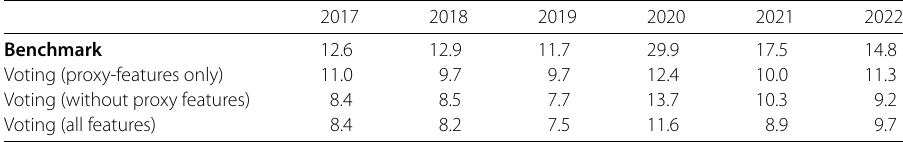
Table 7 Contrasting MAPE accuracies between models using all features versus those generated by proxy-only features for Clinic